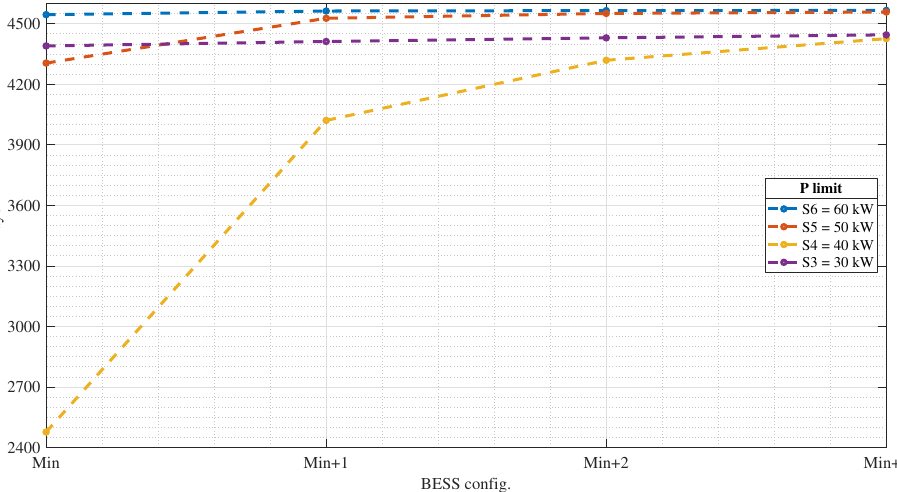
Figure 11. Days until ∇ Q = 20% as a function of the BESS configuration in